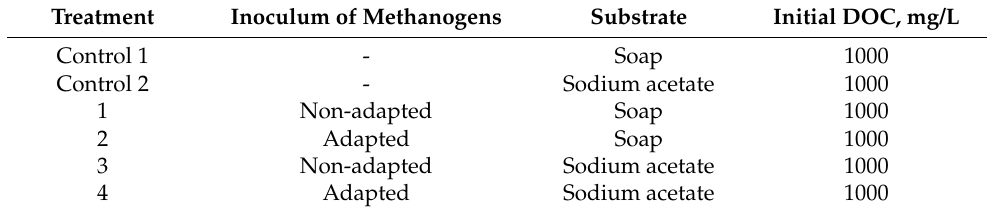
Table 1. Design of the experiment. Treatment Inoculum of